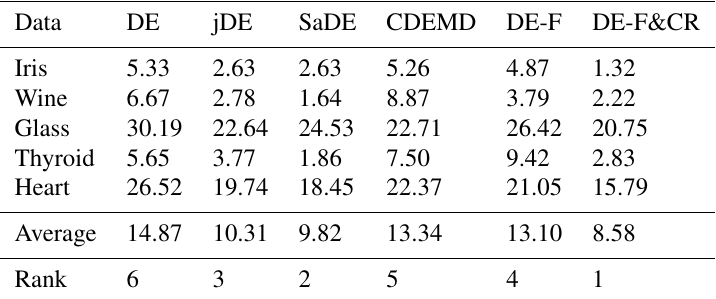
Table 9. Average classification error percentage and